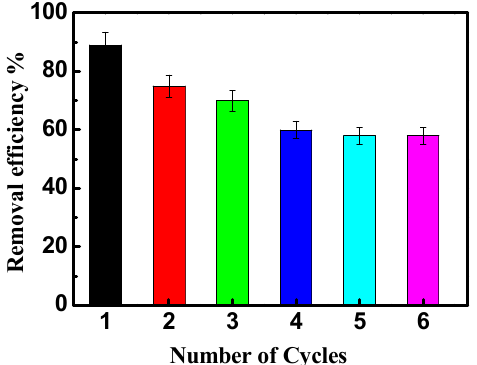
Figure 9. The reusability of NiO/PDA during adsorption of MV2B.